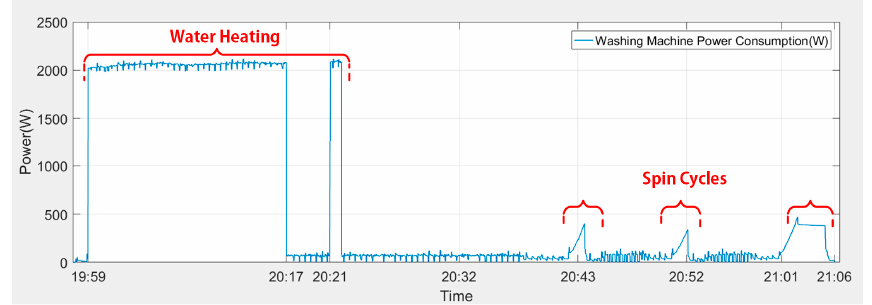
Figure 8. The power consumption of the washing machine for the mixed washing program at 40 °C.